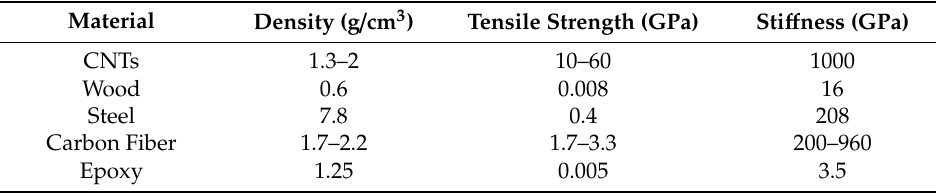
Table 1. Comparison of properties of CNT and other materials. Reproduced from